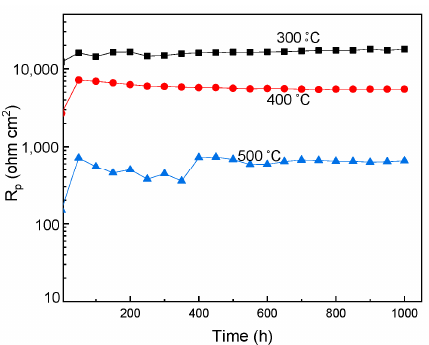
Figure 4. Effect of temperature on the variation of the R p value for T91 steel in 60 wt% NaNO 3 - 40%KNO 3 .